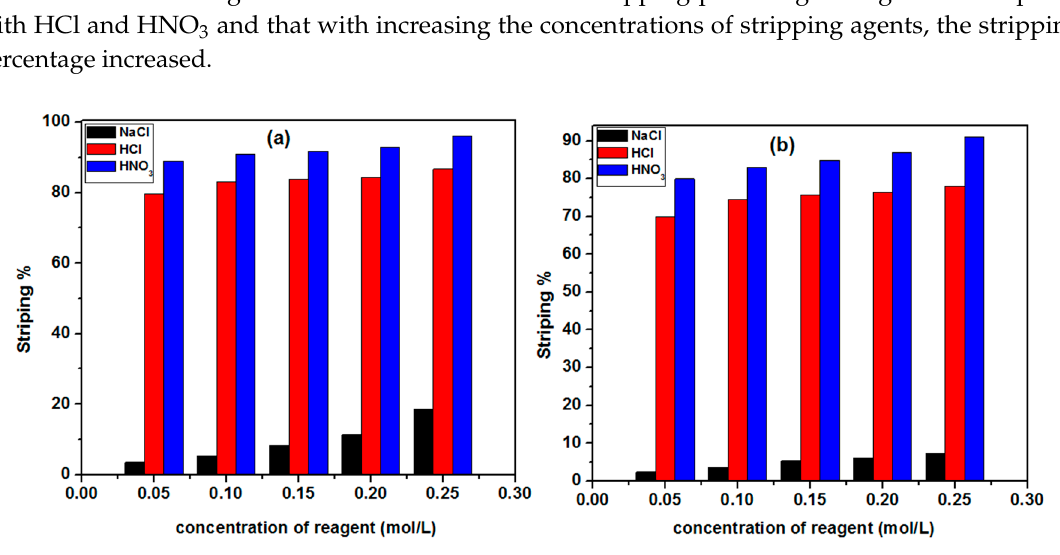
Figure 16. Effect of NaCl, HCl, and HNO 3 on stripping percentage of ( a ) U(VI) and ( b ) Th(IV) from HQ-bentonite.